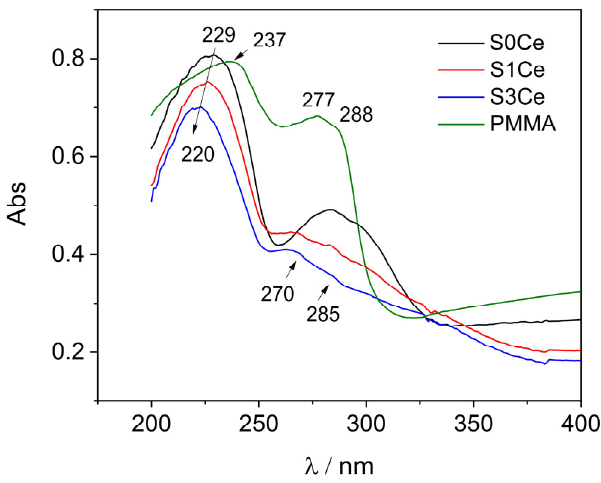
Figure 3. UV-Vis spectra of PMMA-MBGs composite scaffolds in direct comparison with pristine PMMA absorption spectrum.